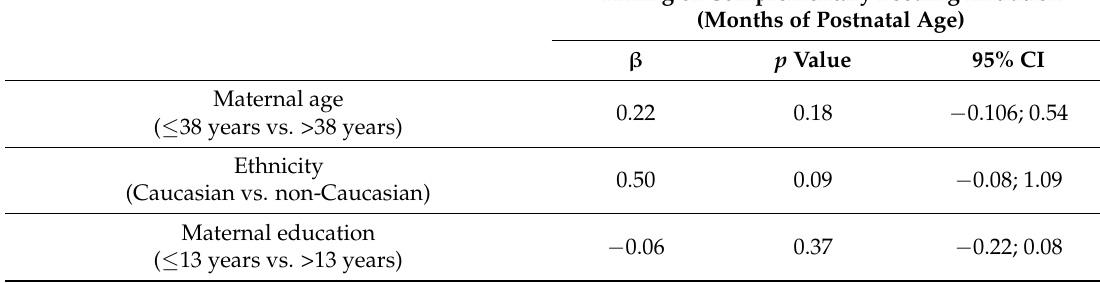
Table 4. Multivariate regression analysis of the association between maternal characteristics, infant’s characteristics, mode of feeding at three months, type of first complementary food and timing of complementary